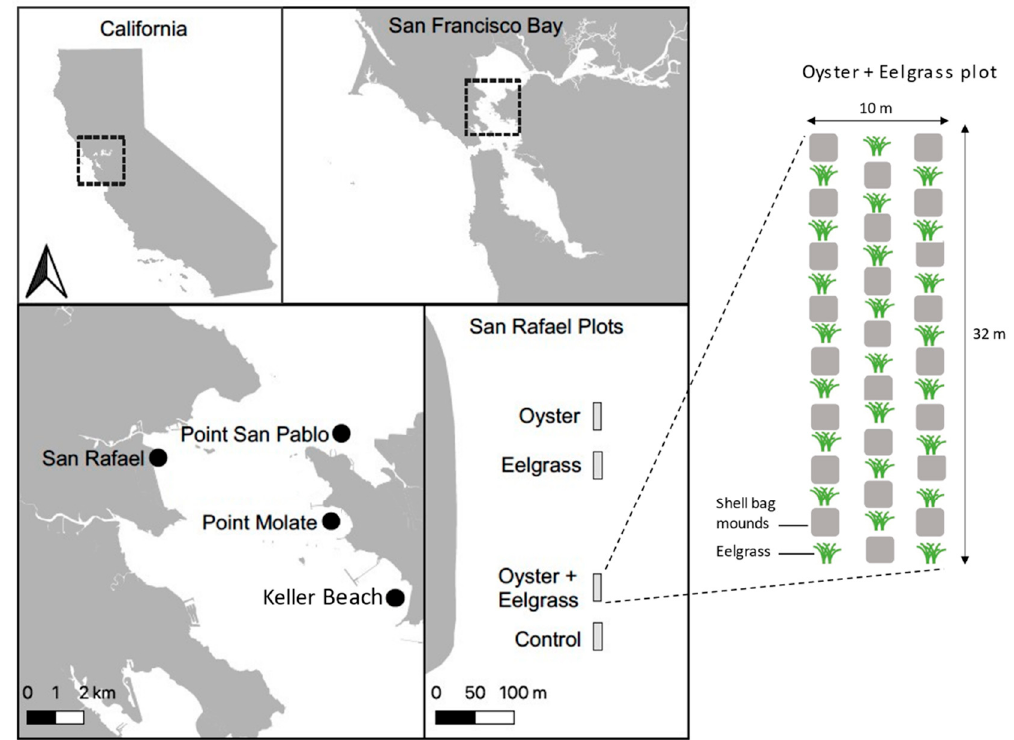
Figure 1. Map of study site location (San Rafael, Marin County, California, ’SR’; 122 ◦ 29’15” W, 37 ◦ 57’47” N), as well as layout of treatment plots. Transplanted eelgrass was sourced from natural beds across the bay at Point San Pablo (‘PSP’; 122 ◦ 25’02” W, 37 ◦ 58’06” N) and Point Molate (‘PM’; 122 ◦ 24’47” W, 37 ◦ 56’36” N). In addition to samples collected from the study site, eelgrass shoot samples were collected at natural beds at Keller Beach (‘KB’; 37 ◦ 55’15” N, 122 ◦ 23’12 W) and Point Molate to compare invertebrate